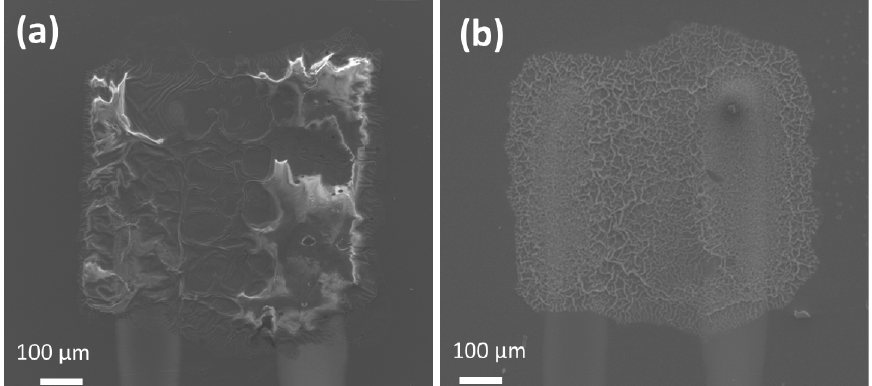
Figure A2. Low-magnification FE–SEM images of two samples before ( a ) and after heat treatment ( b ).